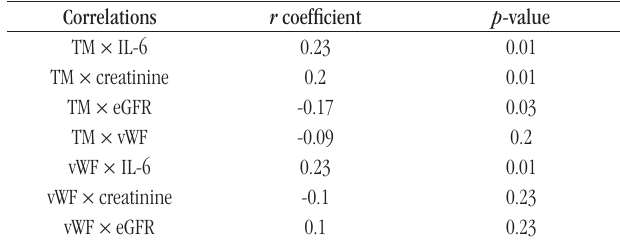
taBLE 2 − Correlation analysis between TM, vWF, IL-6 and plasma creatinine